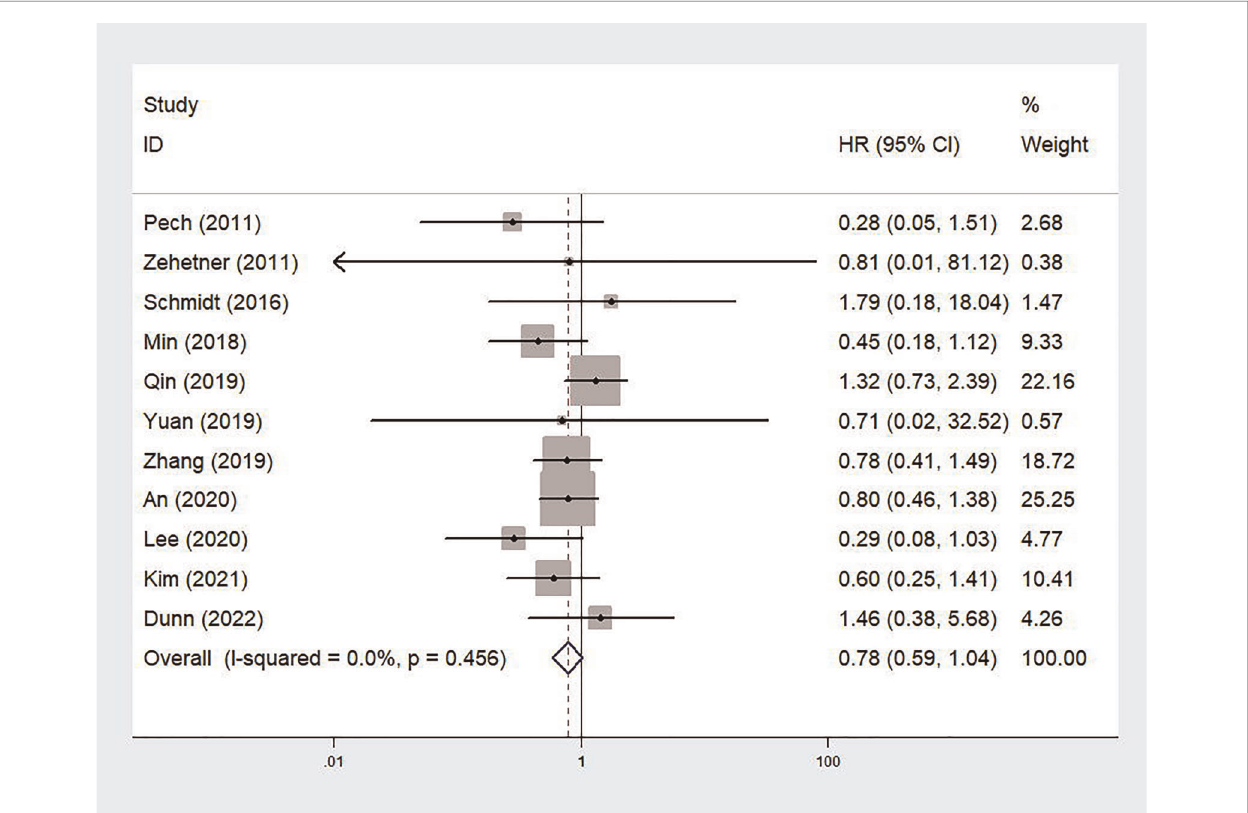
FIGURE 2 | Comparison of overall survival between patients receiving endoscopic dissection and